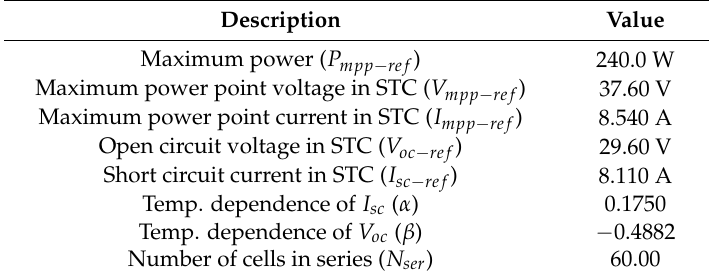
Table 6. Key specifications of GSP-240 PV Module.